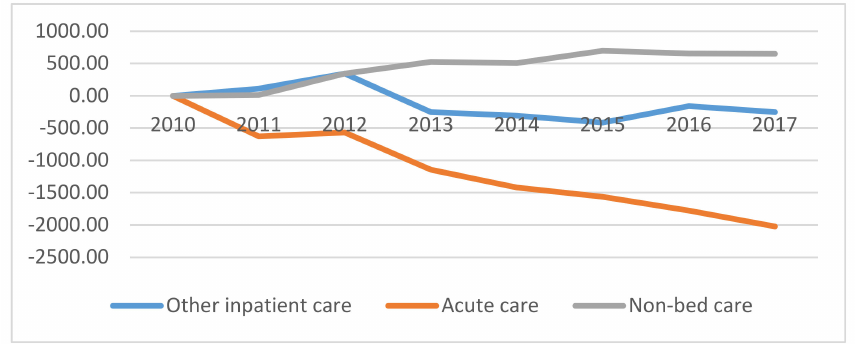
Figure 1. Development of the full-time equivalents of general nurses from 2010 in the Czech Republic.